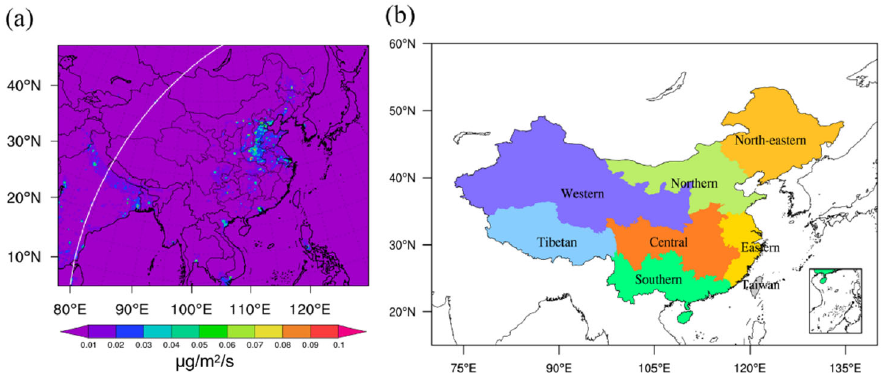
Figure 1. ( a ) Map of study domain and distributions of the mean BC emissions in March 2018, the full disk scanning of Himawari-8 over the study domain is shown in the white line. ( b ) The zoning map of seven main electricity grids in China.